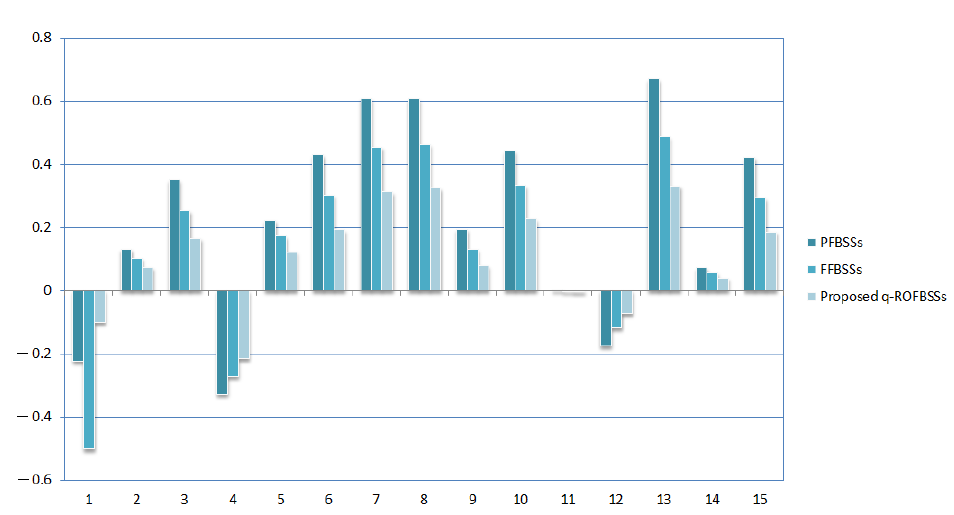
Figure 3. Comparison between PFBSSs [28], FFBSSs [30], and proposed q -ROFBSSs by applying on Application 2 (Selection of a house) in